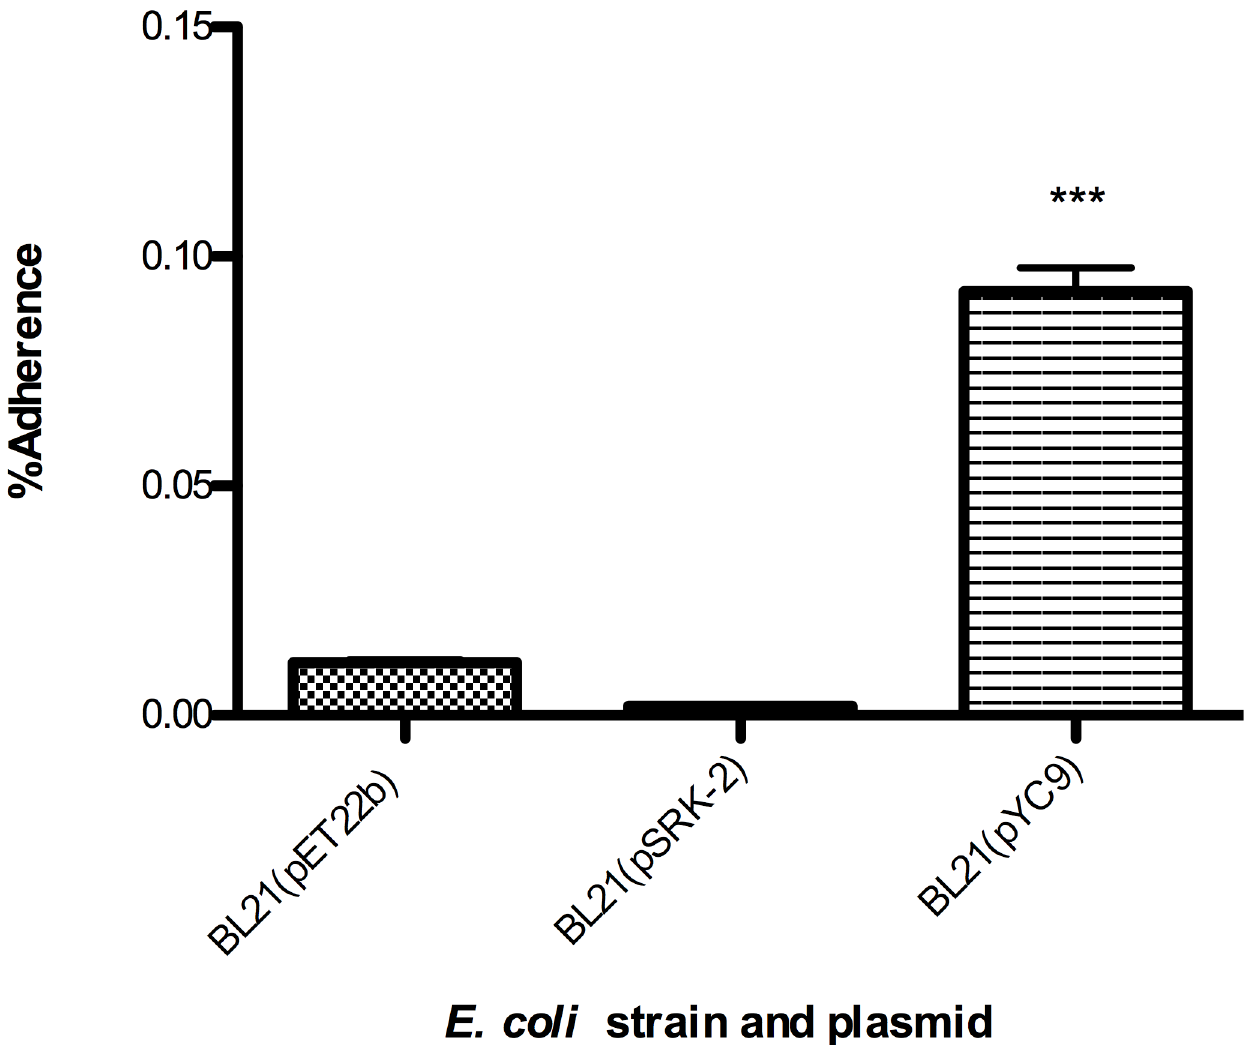
Fig 6. Adherence potential of R . conorii Adr2 expressing E . coli . Expression of R . conorii Adr2 in E . coli (BL21) is not sufficient to mediate cell adherenceto EA.hy926 cells. The results are expressedas percentages of recovered adherentbacteria basedon the total bacterial input. Results are shown as the mean ± SD (P values: *** <